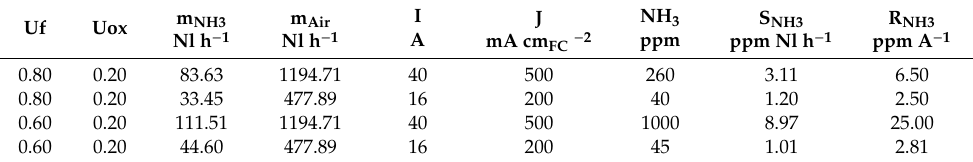
Table 8. O ff -gas measurements of NH 3 emissions for pure ammonia tests.